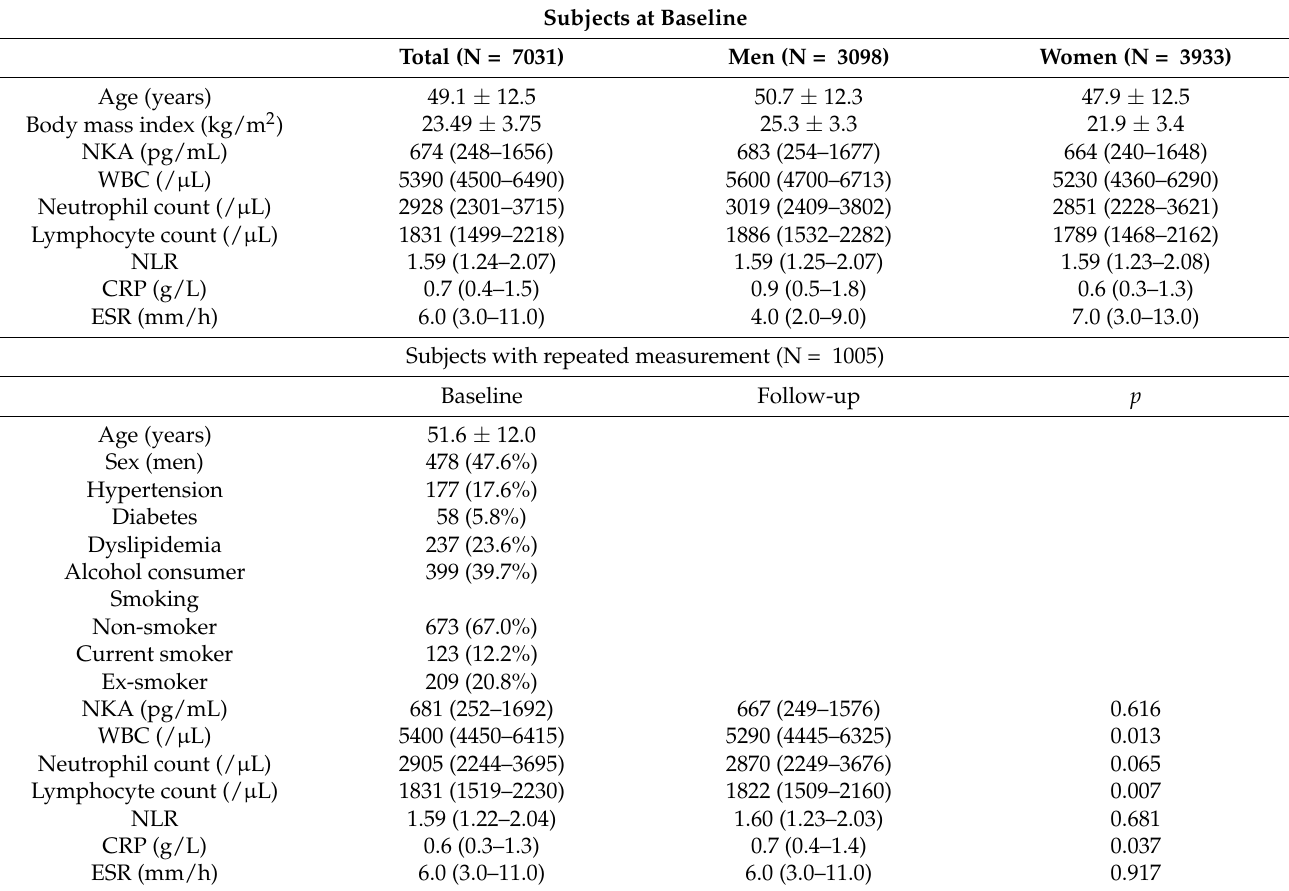
Table 1. General characteristics of the